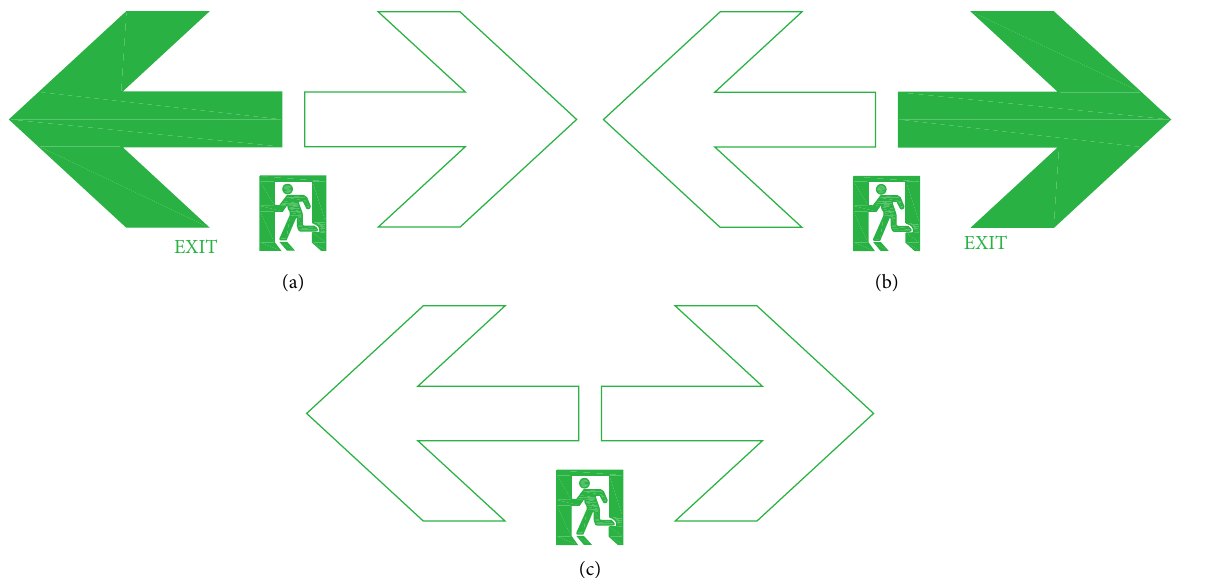
Figure 1: Dynamic sign with different guidance direction. Figure (a) denotes a guidance to the left with green arrow, Figure (b) denotes a guidance to the right with green arrow, and Figure (c) denotes no guidance.